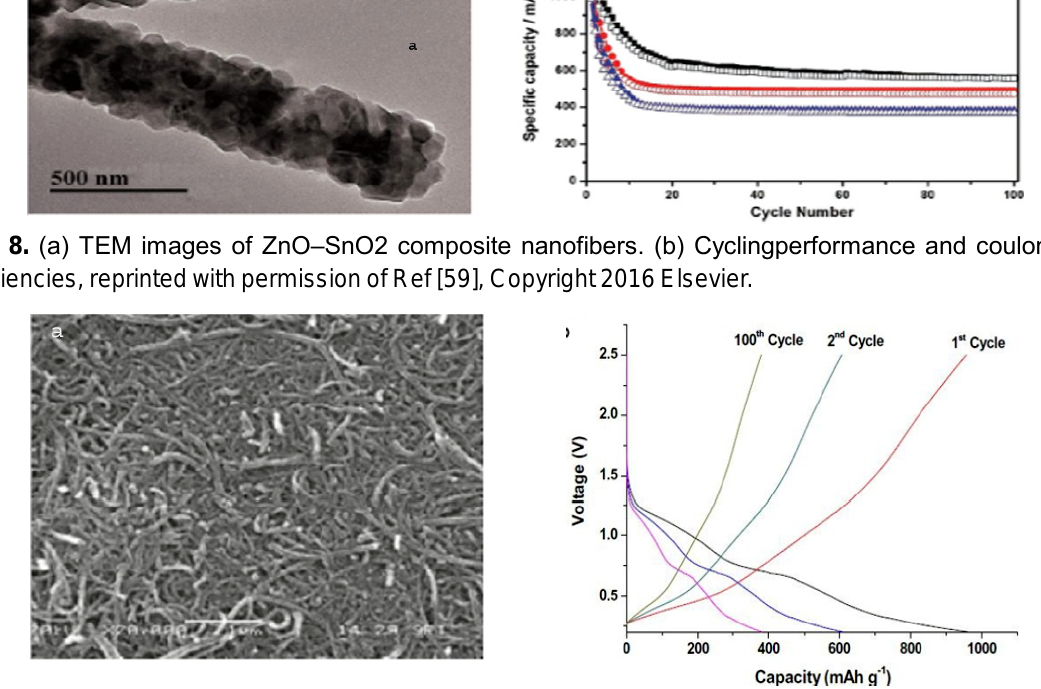
Fig. 9. (a) SEM and HRTEM images of the films oxidized under at high purity oxygen (99.999%) and argon (99.9999%) in a ratio of (a) 1:4,(b) Galvanostatic charge–discharge curves of the films oxidized under (a) 1:4, (Oxygen:Argon) gas pressures, reprinted with permission of Ref [60], Copyright 2014